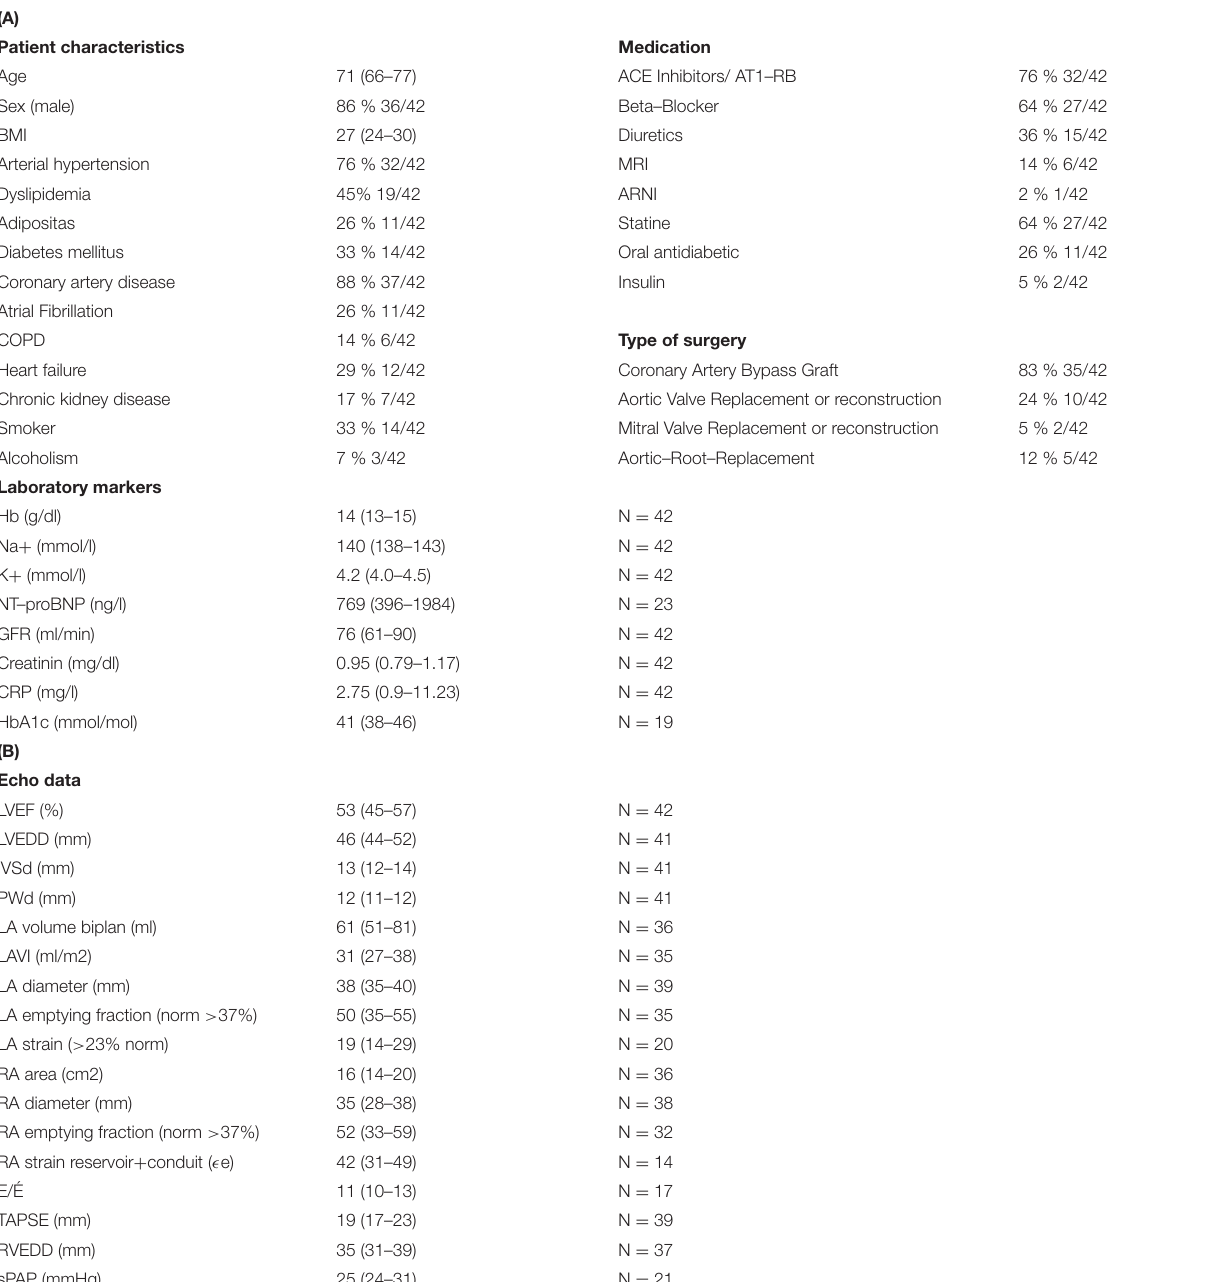
TABLE 1 | Patient